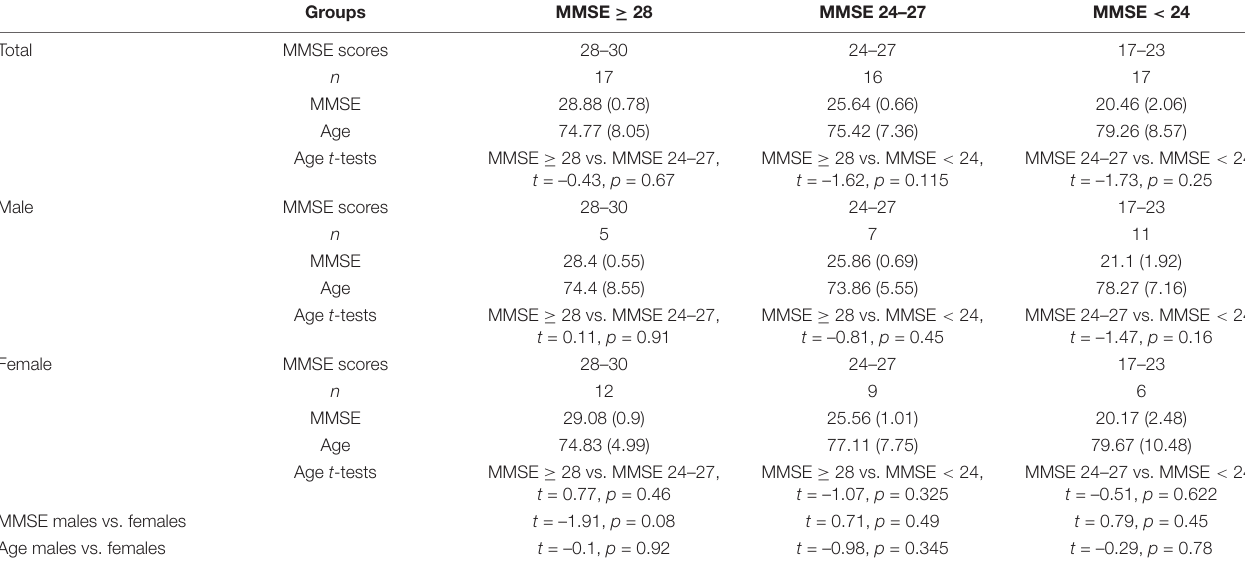
TABLE 1 | Demographic information of the senior groups included in the